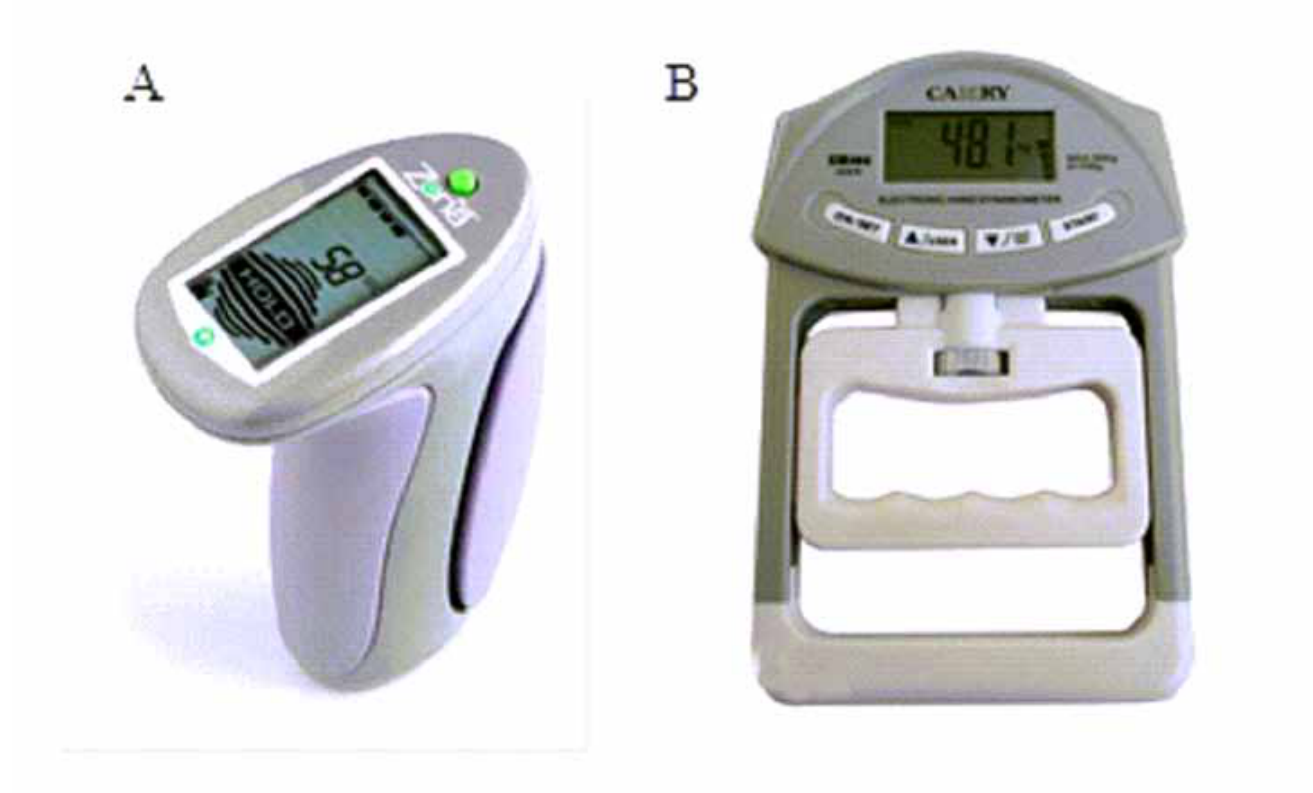
variables measurements, the patients will be instructed to avoid physical exercise for at least 24 hours prior to the visit, avoid smoking, alcohol and caffeine ingestion for at least 12 hours and to eat a light meal before arriving at the laboratory.